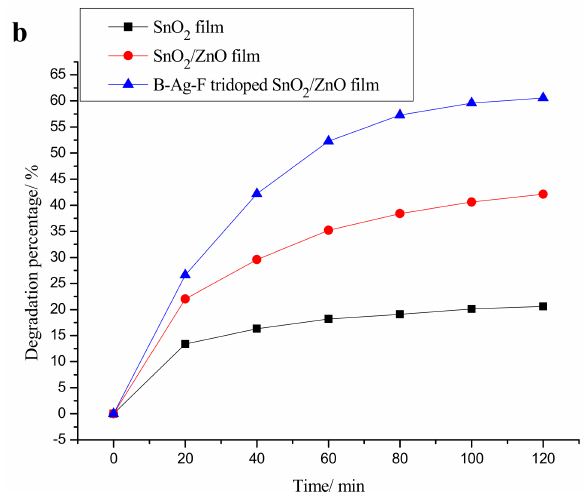
Figure 2. The decomposition kinetics of the ( a ) methyl green and ( b ) formaldehyde solutions employing pure SnO 2 , SnO 2 -ZnO, and B/Ag/F tridoped SnO 2 -ZnO films under visible irradiation for 120 min.